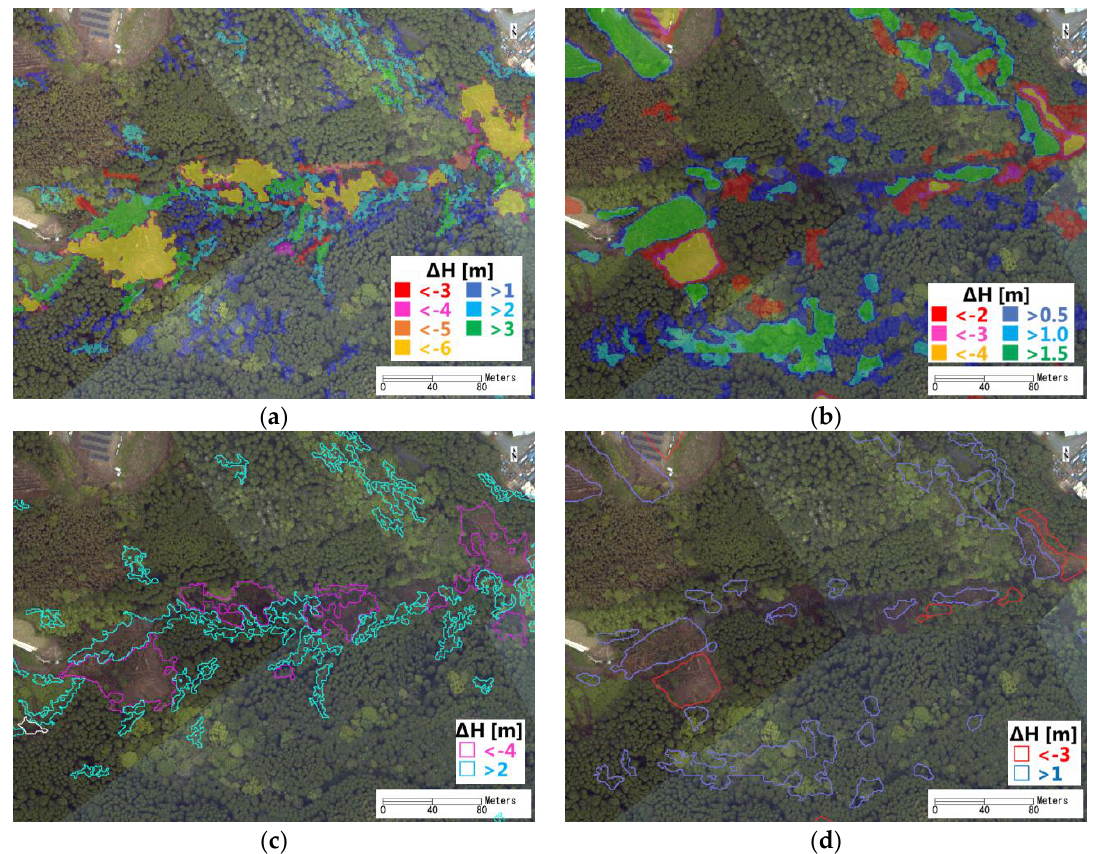
Figure 8. ( a , b ) Comparison of the different threshold values for extracting the erosions and the depositions from the DSMs and the DTMs. ( c , d ) The extracted regions using the optimal threshold values from the DSMs and DTMs, respectively. The background image is the ortho-image acquired on 23 April 2016.